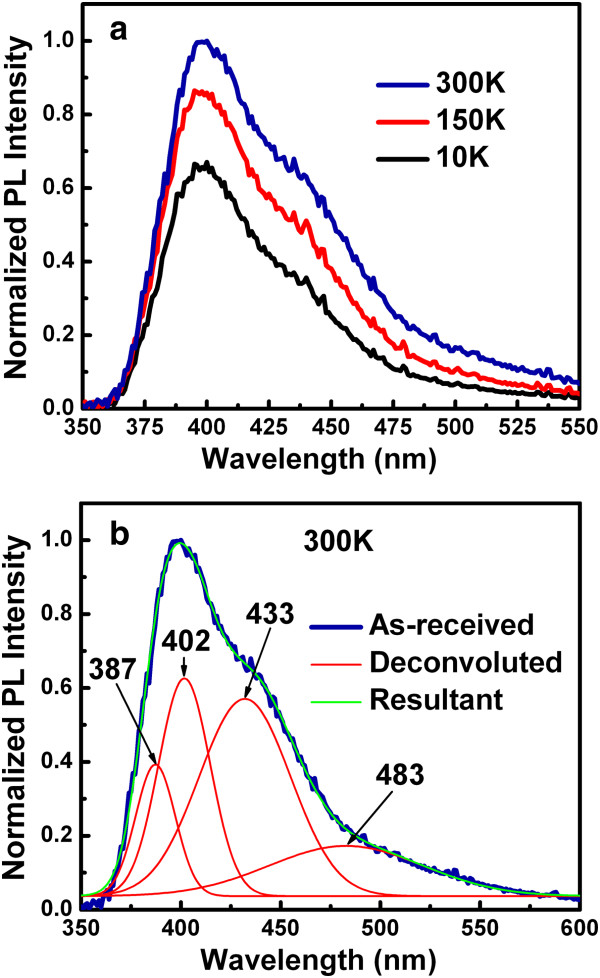
PL and deconvoluted spectra. PL spectra of the Ge/GeOx NWs (a) measured at temperatures of 10 to 300 K and (b) deconvoluted spectra at 300 K.